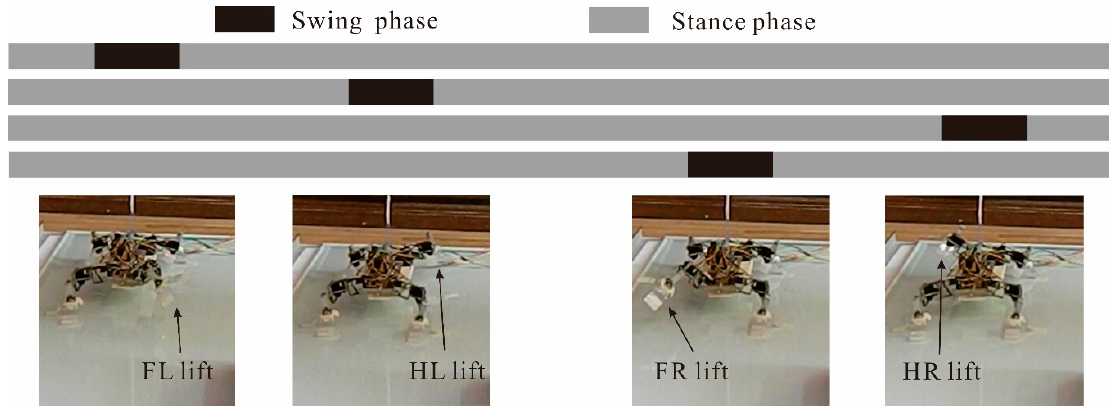
Figure 7. Robot climbing on a glass surface at a RRG of 94%. Photos show different legs in swing phase. phase. FL: Front left, HL: Hind left, FR: Front right, HR: Hind right. FL: Front left, HL: Hind left, FR: Front right, HR: Hind